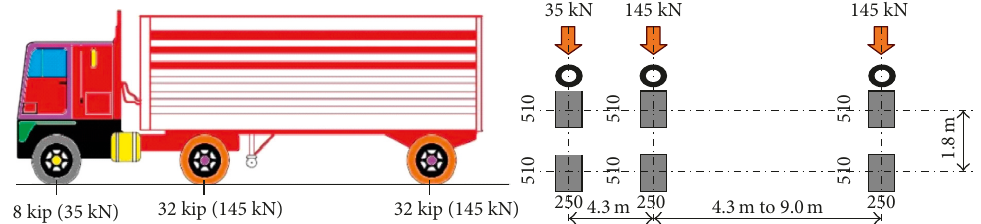
Figure 3: Truck characteristics based on HL93.